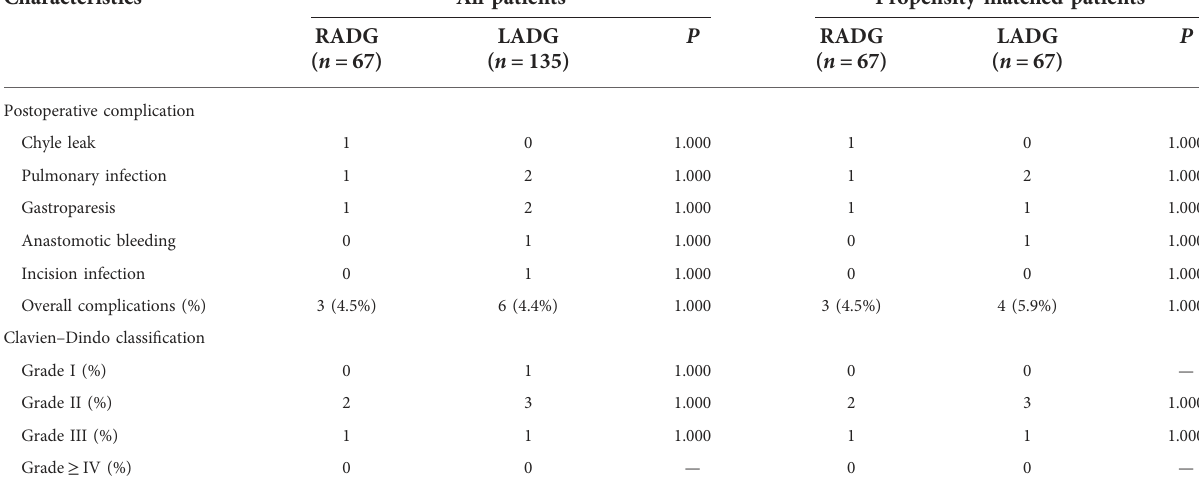
TABLE 5 Postoperative complications.